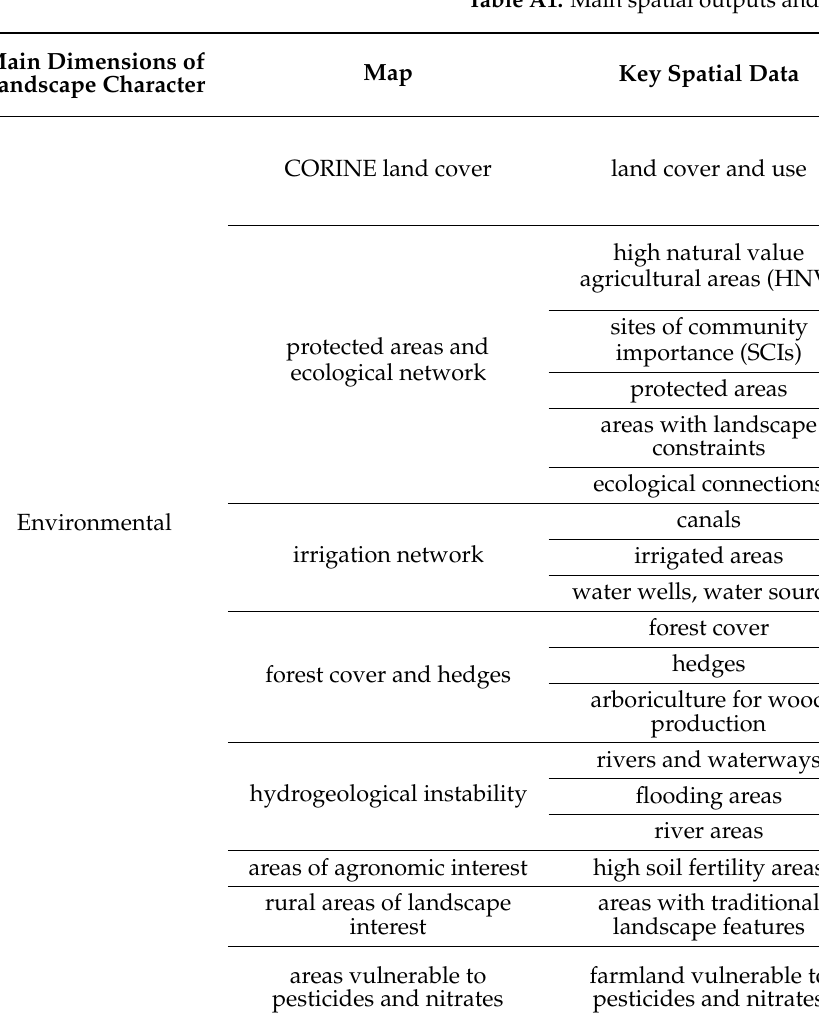
Table A1. Main spatial outputs and datasets for the definition of the knowledge